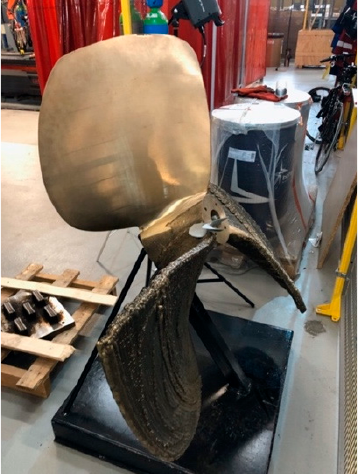
Figure 9. WAAM prototype.